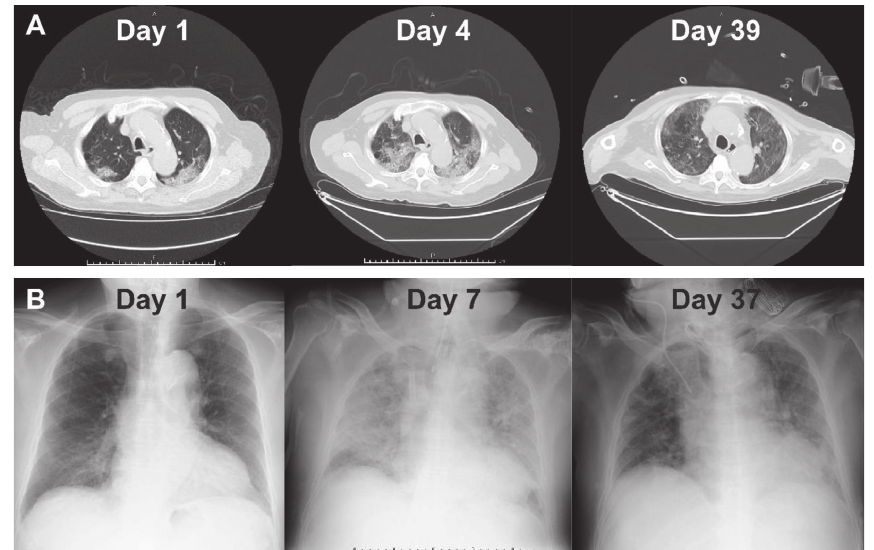
Figure 1: Radiological findings in the patient. (a) Transverse chest CTimages on days 1, 4, and 39. Bilateral infiltrative shadows and ground- glass lesions were apparent, which deteriorated on day 4. On day 39, ground-glass lesions decreased and lung aeration improved. (b) Chest radiographs showing changes in lung opacity over time. An endotracheal tube and blood delivery cannulas for ECMO are visible in the image taken on day 7. These were removed, and a tracheostomy tube is visible in the image taken on day 37.